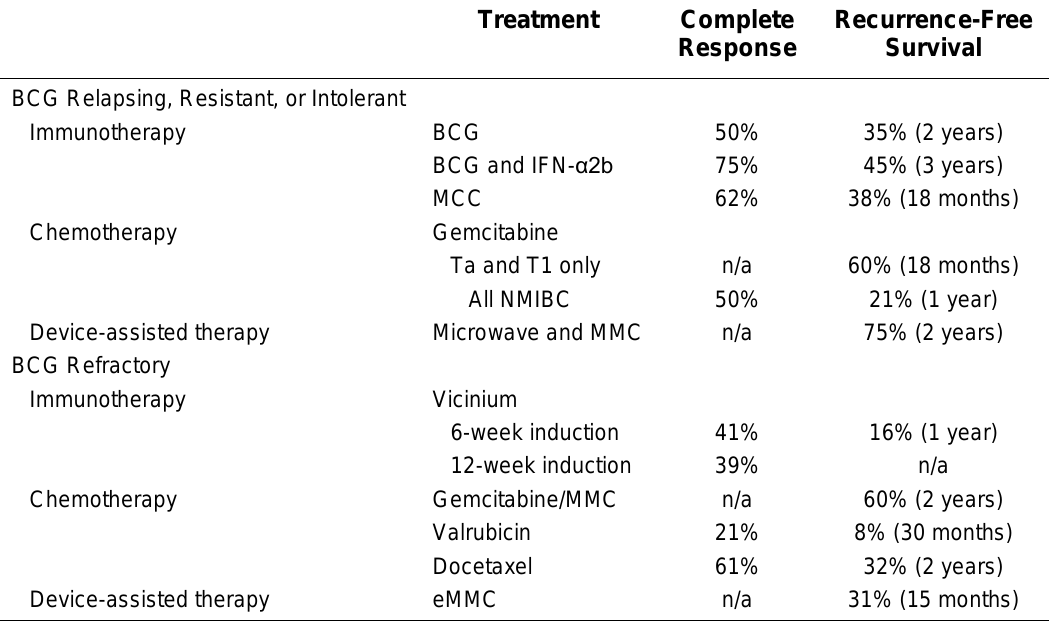
Efficacy of Treatments in Patients Failing BCG Therapy Treatment Complete Recurrence-Free Response